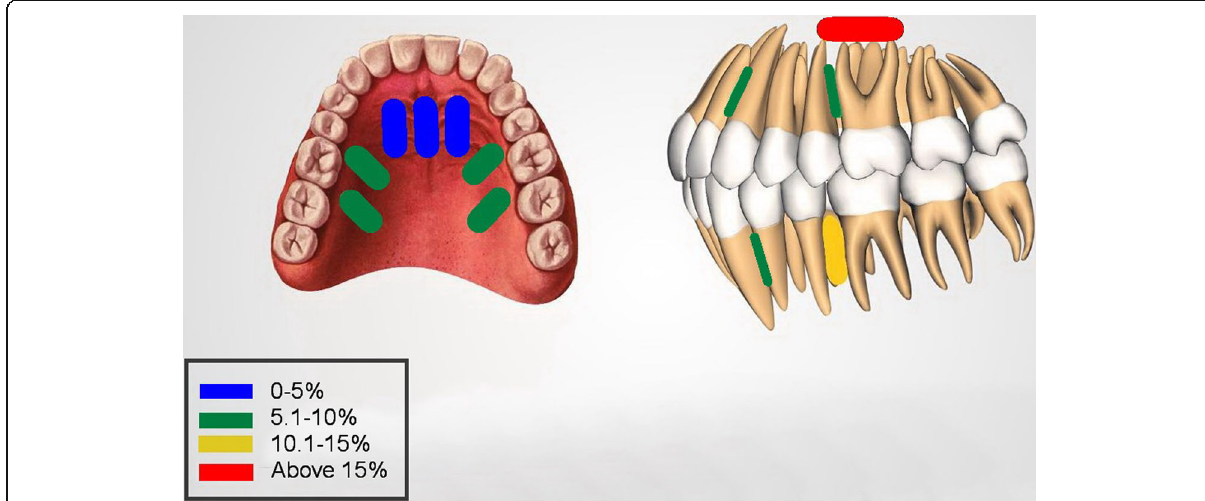
Fig. 12 Diagram demonstrating failure rates obtained from the quantitative